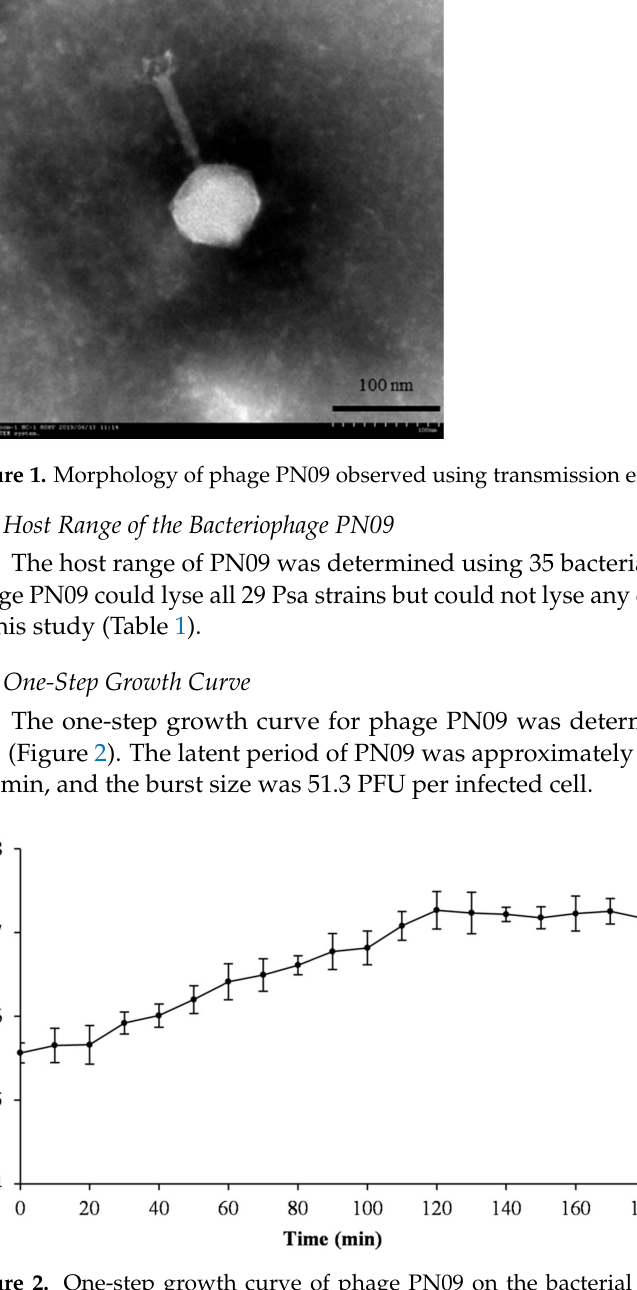
Figure 2. One-step growth curve of phage PN09 on the bacterial host Pseudomonas syringae pv. actinidiae (Psa) strain SCJY02-1 at 27 ◦ C. The means and standard deviations of three independent assays are